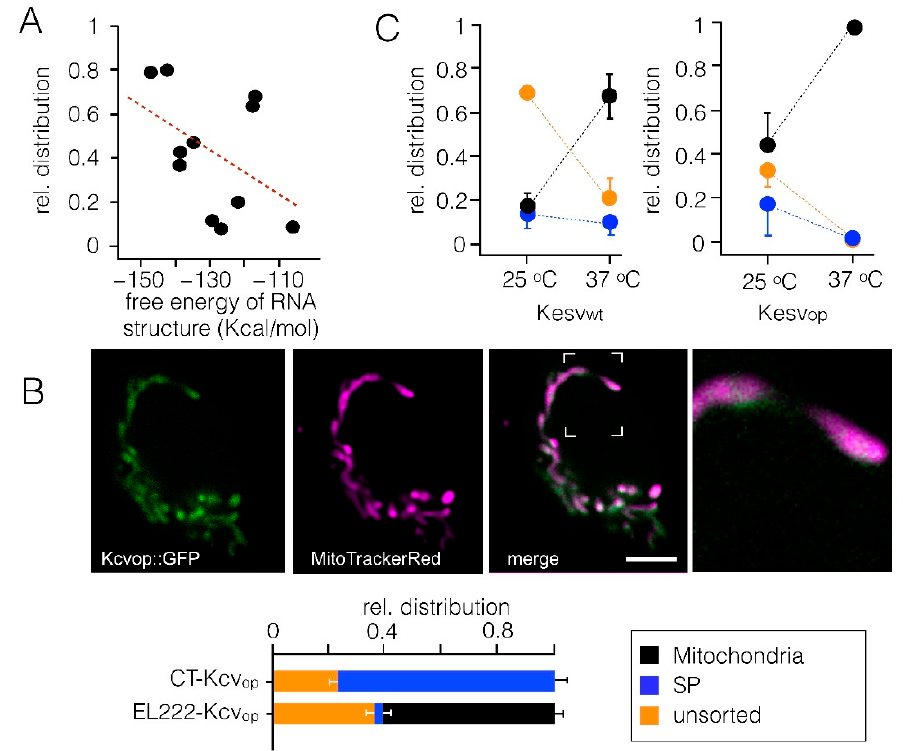
Figure 5. Sorting pattern of the Kesv channel as a function of parameters, which can affect protein synthesis. ( A ) Relative distribution of the Kesv channel in mitochondria from data in 4A as a function of estimated free energy of RNA structures derived for Kesv wt , Kesv ran , Kesv op and chimeras C1-C8. Energies were calculated for channel coding the RNA sequence only. The line shows linear fit with a correlation coefficient of 0.44. ( B ) Light triggered transcription of Kcv op channel shifts sorting propensity from SP to mitochondria. Top: confocal images of representative HEK293 cell expressing GFPtagged Kcv op (green, 1 st panel) and stained with MitoTrackerRed (magenta, 2nd panel); merging of green and magenta channels is shown in the 3 rd panel with a blow up of the indicated area in the 4th panel. Bottom: relative distribution for localization of the Kcv op channel in mitochondria, SP, or unsorted channels in HEK293. Protein was expressed in HEK293 cells by conventional transfection (CT) or under control of a light-sensitive EL222 system [25,44]. In the latter case, transcription was induced by a pulsed blue light of 120 μ E, which was applied for 16 h prior to imaging. Light pulses were 10 s/20 s on followed by 60s of darkness. Data are from n cells in N independent experiments: CT-Kcv Op n = 3, n = 237 and EL222-Kcv Op n = 3, n = 118. Scale bars 10 μ m. ( C ) Sorting of the channel to the three destinations (mitochondria: black, SP: blue and unsorted: orange) was estimated as in Figure 1 in HEK293 cells transfected with Kesv wt (left panel) and Kesv op (right panel). Cells were kept either at 37 °C or 25 °C. Lowering the temperature is unfavorable for channel sorting to the mito- chondria. The lower temperature favors non-sorting and sorting to the SP. Mean values ± S.D. of n = 3 experiments with ≥ 270 cells per temperature. Color coding is the same as in B.